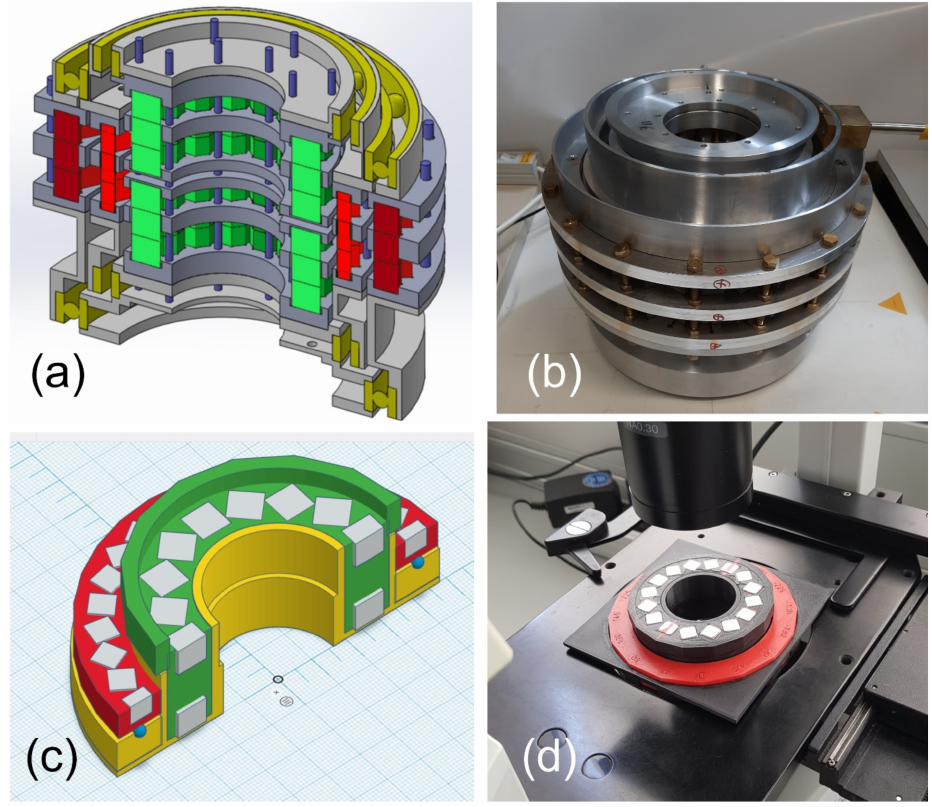
Figure 8. Examples of two constructed guiding systems: ( a ) Cut-away view of a schematic drawing of the larger device. The innermost opening has a diameter of 10 cm, outer diameter is 36 cm, and the total height is 27.5 cm. It consists of a static Halbach dipole (magnets in green) and two quadrupoles (darker and lighter red) that can be rotated. In gray are aluminum and in blue brass supports; ball bearings are in yellow. ( b ) Constructed system with a homogeneous field of 325 mT and gradients from 0 to 2.1 T/m. The complete system has a weight of ca. 100 kg. ( c ) Cut-away view of a schematic drawing of the smaller device; the larger squares on the light-blue pad have a size of 1 cm. The magnets in both dipole (green with two magnet layers) and quadrupole (red) are shown in gray. Supports are in yellow and glass balls, which serve as bearings, are in blue. ( d ) 3D printed version of ( c ) used in a light microscope. It has a homogeneous field of ca. 100 mT and a gradient of ca. 1.3 T/m, which both can be rotated independently. It weighs 273 g. More information about both systems can be found in the supporting material of